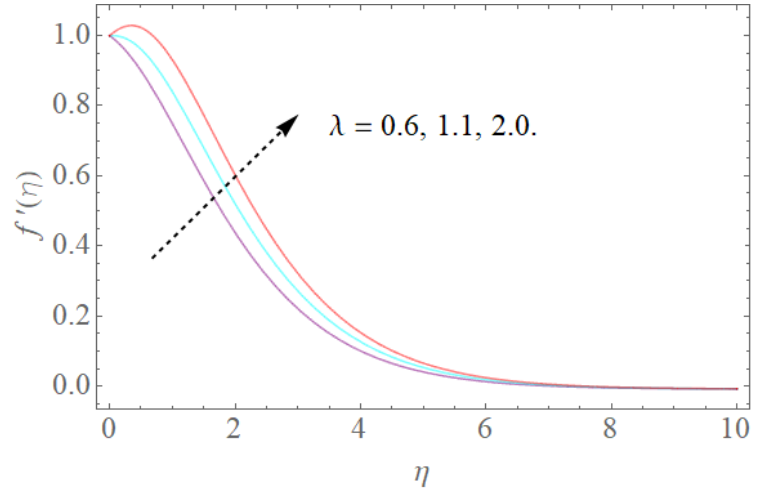
  f  1.0, Figure 5. The effect of  on when 1    g η a , , s  on the dimensionless-made magnetic field along the x  c   f     g η 1.0, Figure 5. The effect of λ on f (cid:48) ( η ) when β = 1.0, k 1 = 1.2, R b = 0.4, N r = 2.0. Figure 5. The effect of  on when are shown in Fig- 1 2.2. Dimensionless Induced Magnetic Field along x − Direction g (cid:48) ( η ) The impacts of β , s , a on the dimensionless-made magnetic field along the x − direction c g (cid:48) ( η ) have been shown in Figures 6 and 7. The impacts of the magnetic parameter ( β ) and the ( a / c ) suction or injection parameter on g (cid:48) ( η ) are shown in Figure 6. It is very clear that by growing the values of ( β ) , g (cid:48) ( η ) reduces. We notice that an increment in ( β ) summons    g η . Figure 7 portrays the impact of an attractive field upgrade (Lorentz power increase) and furthermore dimensionless g (cid:48) ( η ) .    g η Figure 6 also shows the effect of ( a / c ) on g (cid:48) ( η ) . As a result, a decrease in ( a / c ) leads to . Increasing the suction or reducing g (cid:48) ( η ) . Figure 7 portrays the impact of the suction/injection parameter over the    g η profile, but at that point, as we grow in velocity profile g (cid:48) ( η ) . Increasing the suction or injection parameter initially reduces the g (cid:48) ( η ) profile, but at that point, as we grow in the direction of the center of the hydrodynamic edge stream, its pattern changes to the reverse direction. reverse direction.